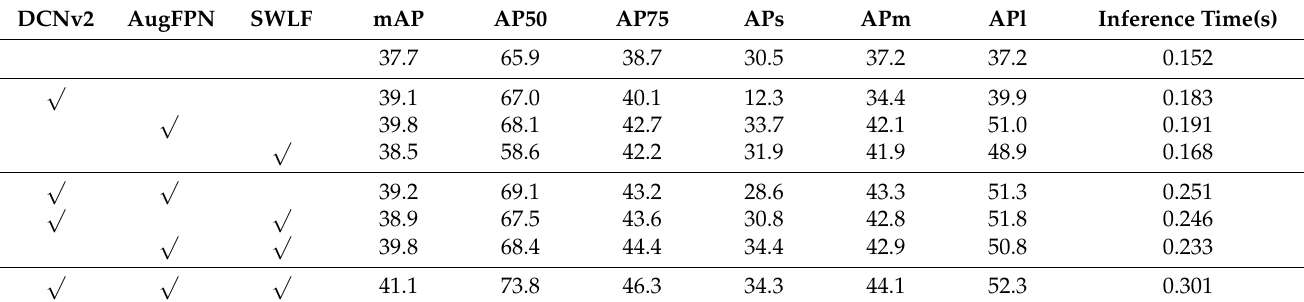
Table 5. The Contribution of Each Component in DASNet.